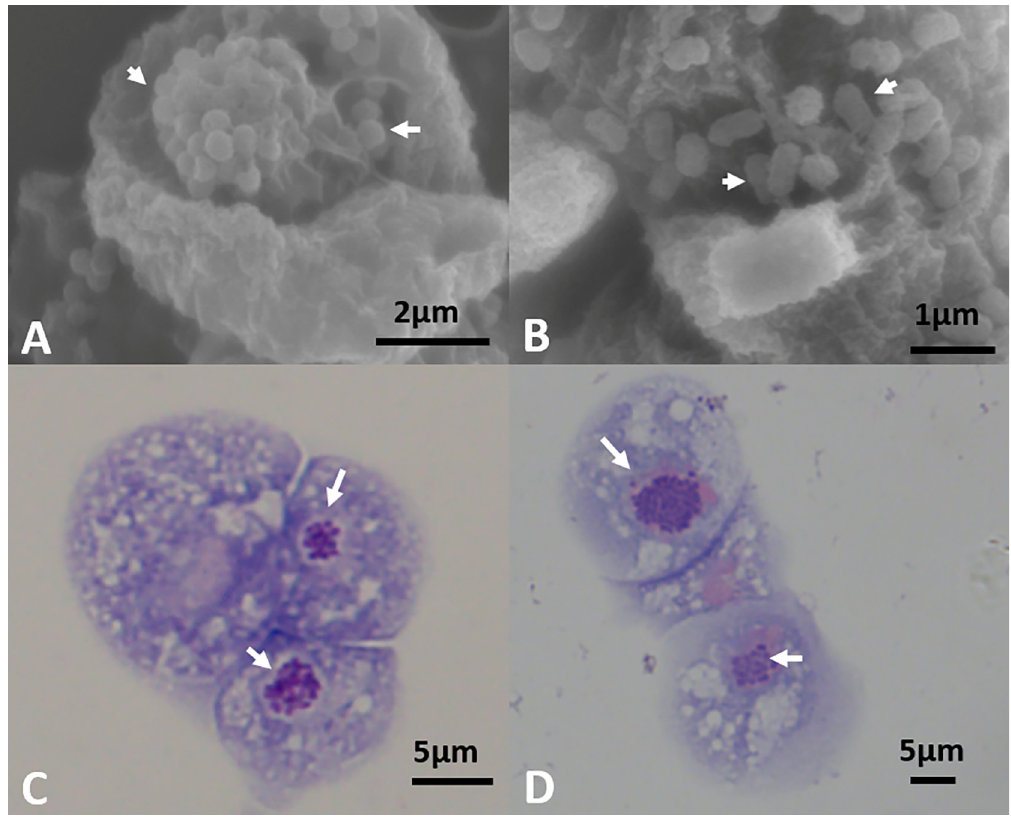
Fig 1. Protozoa infected with “ Ca . B. cookevillensis” (CC99) or “ Ca . B. aquae” (HT99). Electron micrograph (13,000x magnification) of intracellular CC99 (arrow) exhibiting coccoid morphology following exposure of the BCV by the tape ripping technique (A). Micrograph of adherent HT99 (arrow) on the surface of A . polyphaga exhibiting coccobacillus morphology (20,000x magnification) (B). Giemsa staining of D . discoideum (strain AX2) infected with CC99 (C) and HT99 (D) showing bacteria (arrow; dark purple) associated with nuclei